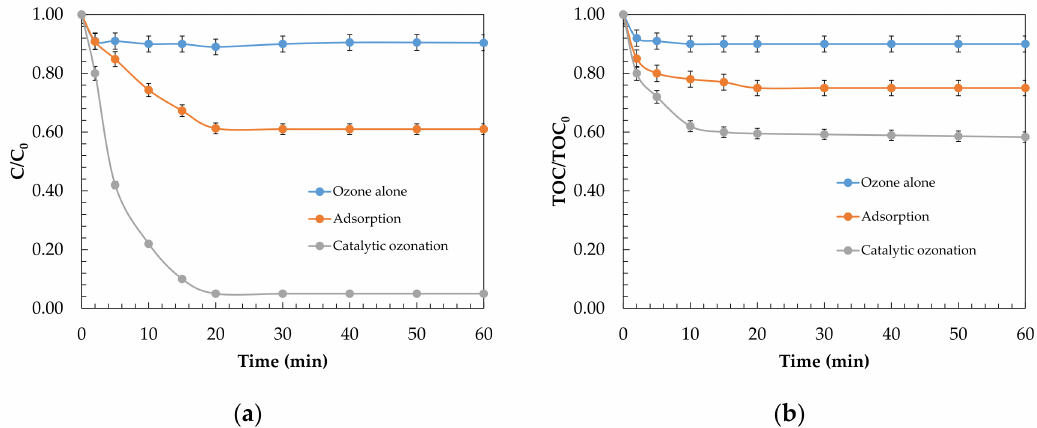
Figure 1. Comparison of ozonation alone, adsorption, and catalytic ozonation processes with GAC in a fixed-bed reactor for phenol removal. Evolution of ( a ) primary degradation and ( b ) mineralisation in terms of TOC. Experimental conditions: C 0 = 250 mg L − 1 ; Q G = 0.05 L h − 1 ; C O , G = 12.0 mg L − 1 ; Q L = 12 mL min − 1 ; pH = 6.5; M CAT = 70.8 g L − 1 ; P = 1.0 atm; 3 T = 20 ◦ C; V = 0.14